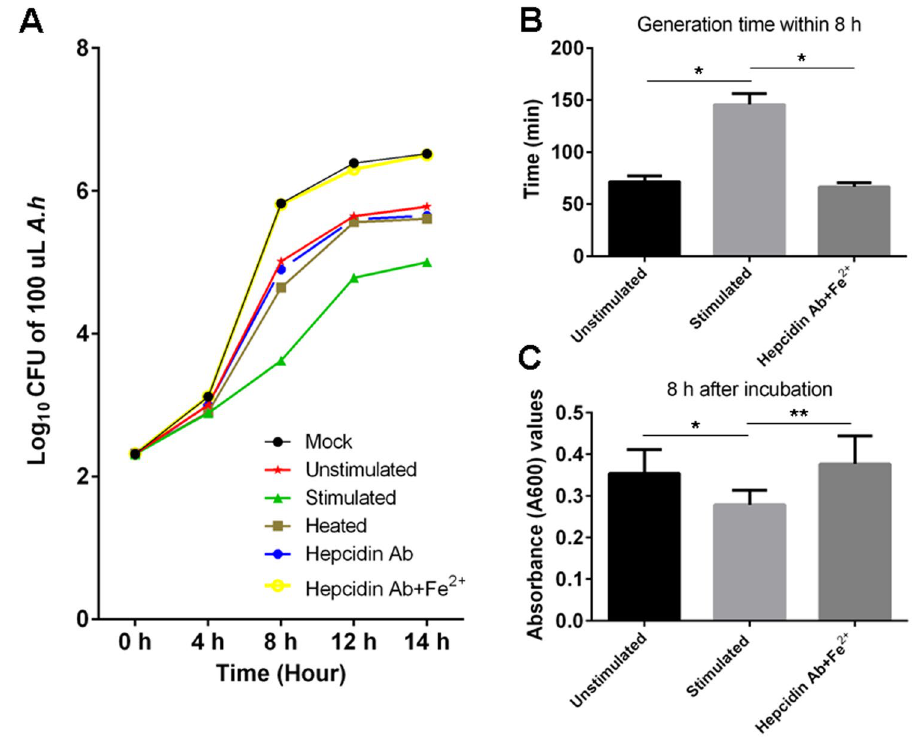
Figure 3. Inhibitory effect of serum derived from A. hydrophila DNA stimulated zebrafish on the growth of A. hydrophila . ( A ) Growth curve of A. hydrophila ( A.h ) in M9 medium cultured in the presence of unstimulated serum (Unstimulated), A. hydrophila DNA (1 μ g per fish) stimulated serum (Stimulated), heat-treated stimulated serum (Heated), stimulated serum neutralized with anti-hepcidin Ab (Hepcidin Ab), stimulated serum neutralized with anti-hepcidin Ab plus 10 μ M Fe 2 + supplemented ones (Hepcidin Ab + Fe 2 + ), and A. hydrophila cultured alone in M9 (Mock). ( B ) Detection of the bacterial generation time of A. hydrophila cultured in the presence of different serum samples (unstimulated, stimulated, and Hepcidin Ab + Fe 2 + ) in M9 medium for 8 h. ( C ) Detection of the absorbance (A 600 ) values of A. hydrophila cultured in the presence of different serum samples (unstimulated, stimulated, and Hepcidin Ab + Fe 2 + ) in M9 medium at 8 h time point. All data are representative of at least three independent experiments. * p < 0.05, ** p <